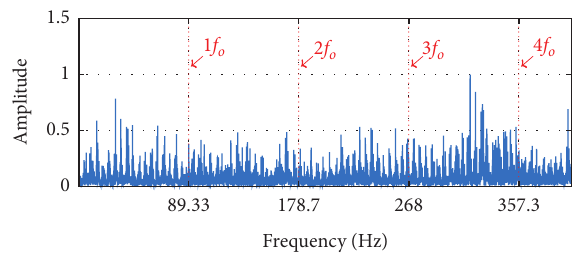
Figure 12: Results of